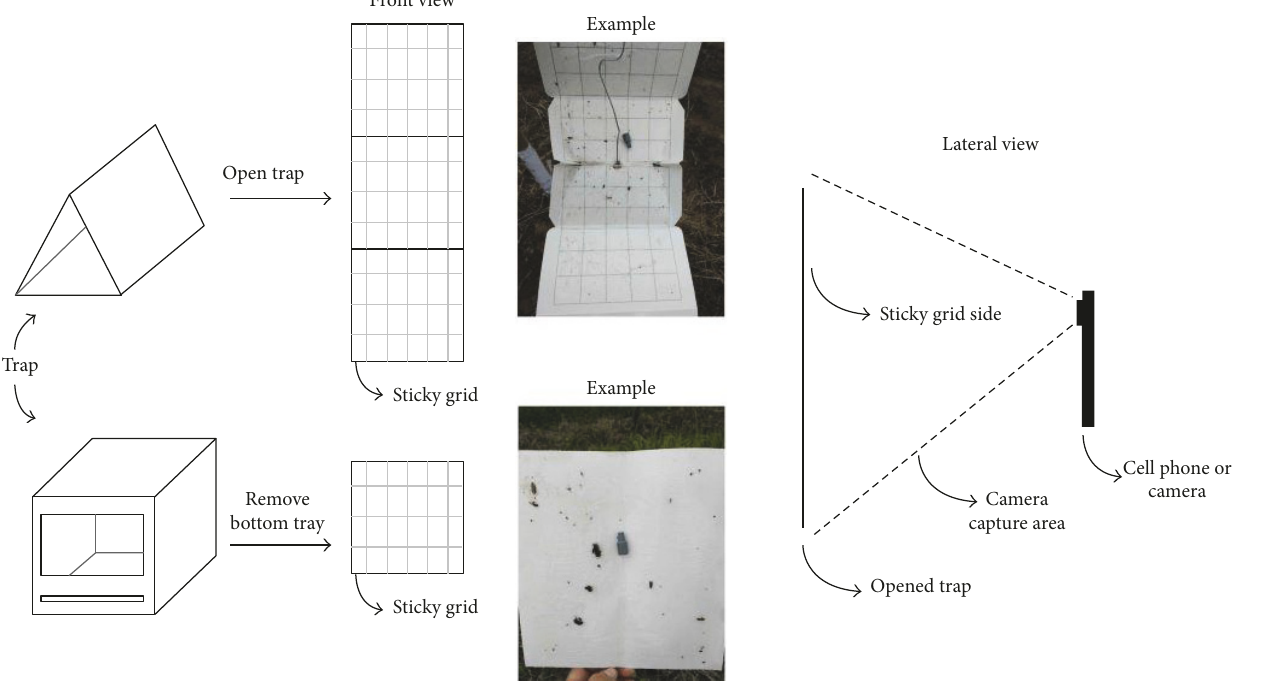
Figure 3: Image capture diagram.